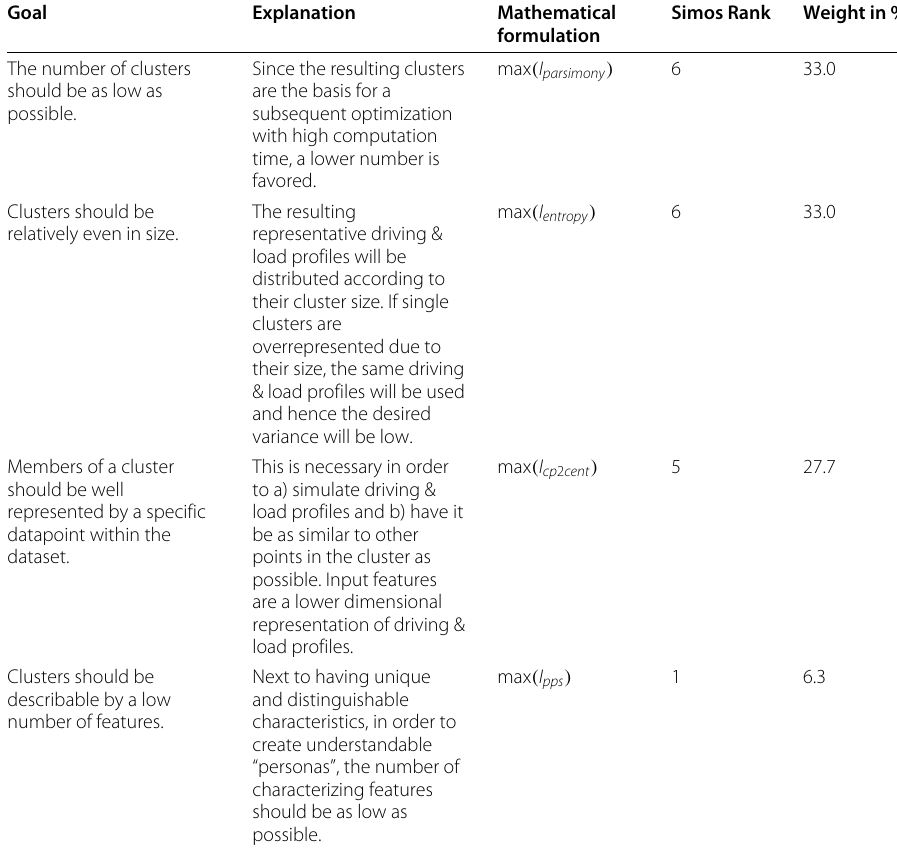
Goal Explanation Mathematical